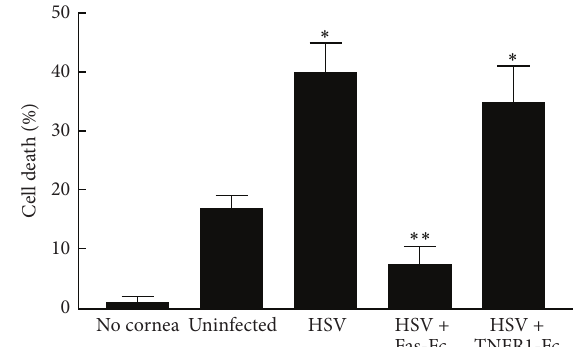
Figure 1: Infection with HSV-1 induces functional Fas ligand. CorneaswereinfectedwithHSV-1,KOSstrain,for24hoursatwhich point [ 3 H]Thymidine labeled L1210-Fas cells (2 × 10 4 ) were cultured in contact with the corneal epithelium in vitro for 20 h at 37 ∘ C. In some cultures the chimeric protein Fas-Fc (10 𝜇 g/mL) or TNFR1- Fc (10 𝜇 g/mL) was included for the entire incubation period. The amount of apoptotic cell death was determined by calculating per- cent of DNA fragmentation. Each value represents the mean of three replicate cultures ± SEM, and each culture condition was performed at least three times. ∗ Infected corneas displayed significantly greater celldeaththandiduninfectedcorneas( 𝑃 < 0.02 ). ∗∗ AdditionofFas- Fc significantly reduced cell death when compared to either HSV alone ( 𝑃 < 0.01 ) or HSV + TNFR1-Fc ( 𝑃 < 0.02